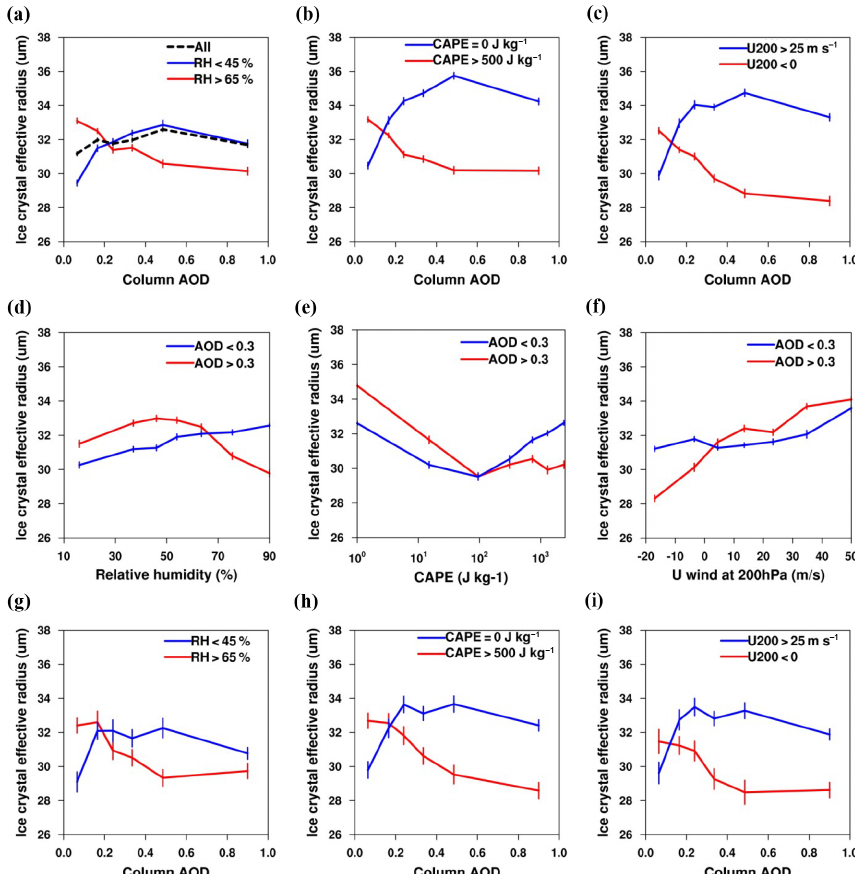
Figure 1. Influence of aerosols on ice crystal effective radius ( R ei ) of ice clouds modulated by meteorological conditions. (a–c) Changes in R ei with AOD for different ranges of (a) RH 100 − 440hPa , (b) CAPE, and (c) U200. (d–f) Changes in R ei with (d) RH 100 − 440hPa , (e) CAPE, and (f) U200 for different ranges of AOD. (g–i) The same as (a–c) but for the profiles with dust aerosols only. The meteorological parameters and AOD are divided into three and two ranges containing similar numbers of data points, respectively; the curves for the medium meteo- √ N ) of the bin average, where σ is the standard deviation and rological range are not shown. The error bars denote the standard errors ( σ/ N is the sample number. The influences of other meteorological parameters are shown in Fig. S2. The total number of samples used in this figure is 5 . 68 × 10 4 .